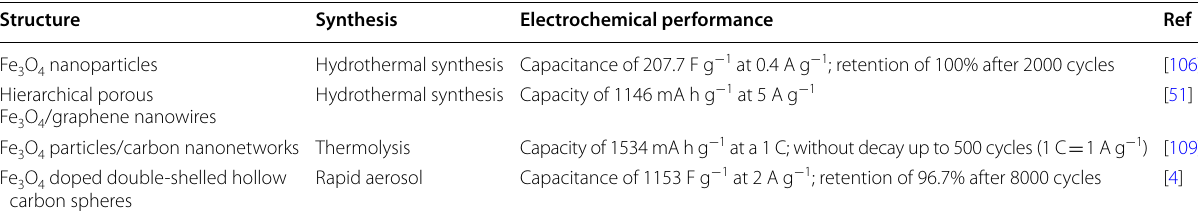
O based nanostructures 3 4